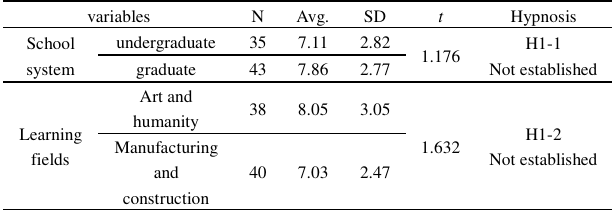
Table 6. Independent-sample t test of content